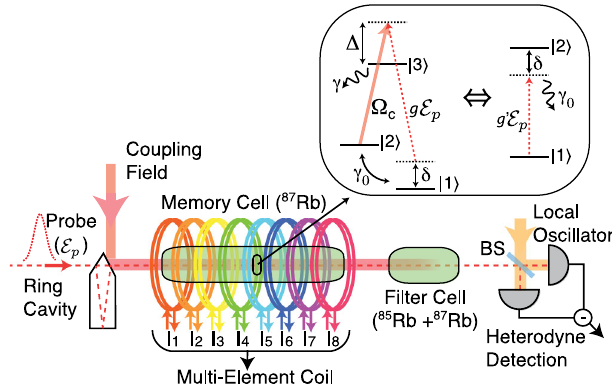
FIG. 2. Experimental setup. Probe electric field envelope ( E ), p nonpolarizing beam splitter (BS), and I 1 – I 8 currents supplied to the individual solenoids. The inset shows the level scheme and the equivalence between the (cid:1) system used and a two-level atom: one-photon detuning ( (cid:2) ), two-photon detuning ( (cid:5) ), ), decay rate from the excited coupling-field Rabi frequency ( (cid:3) c state ( (cid:3) ), decoherence rate between the ground states ( (cid:3) 0 ), coupling strength between ground and excited states ( g ), and the effective coupling strength for the equivalent two-level system ( g 0